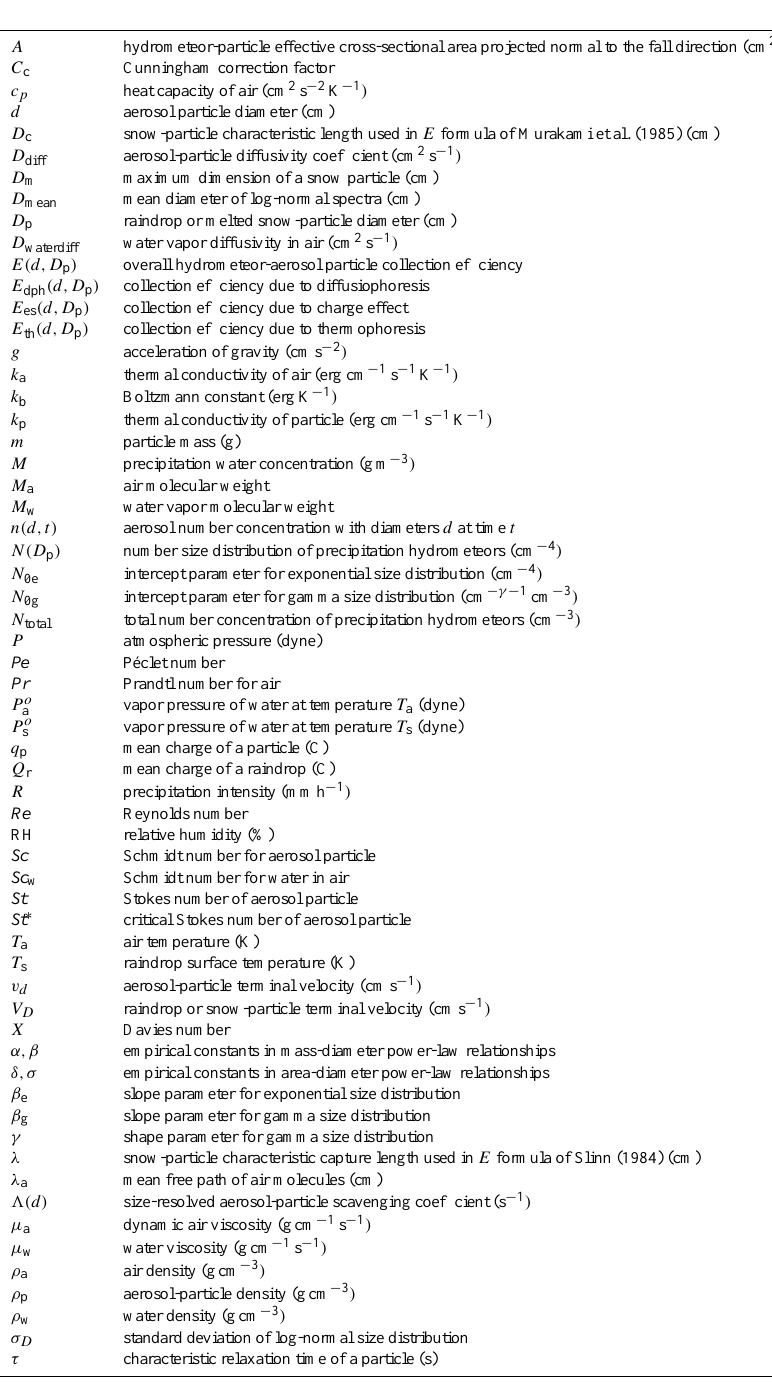
Table E1. Note that CGS units are used in all of the equations and tables except when otherwise stated because many empirical formulas in Tables 1–7 were developed based on CGS